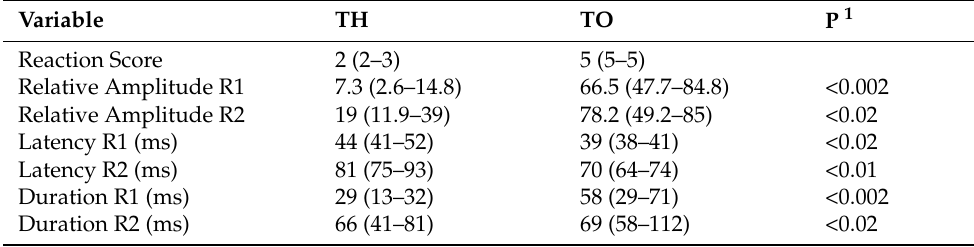
Table 3. Median (interquartile range) values obtained during electromyographic recordings of the right deltoid muscle in 12 horses stimulated over the right lateral palmar digital nerve with lator at various stimulation intensities: nociceptive withdrawal reflex (NWR) threshold (TH) and tolerance